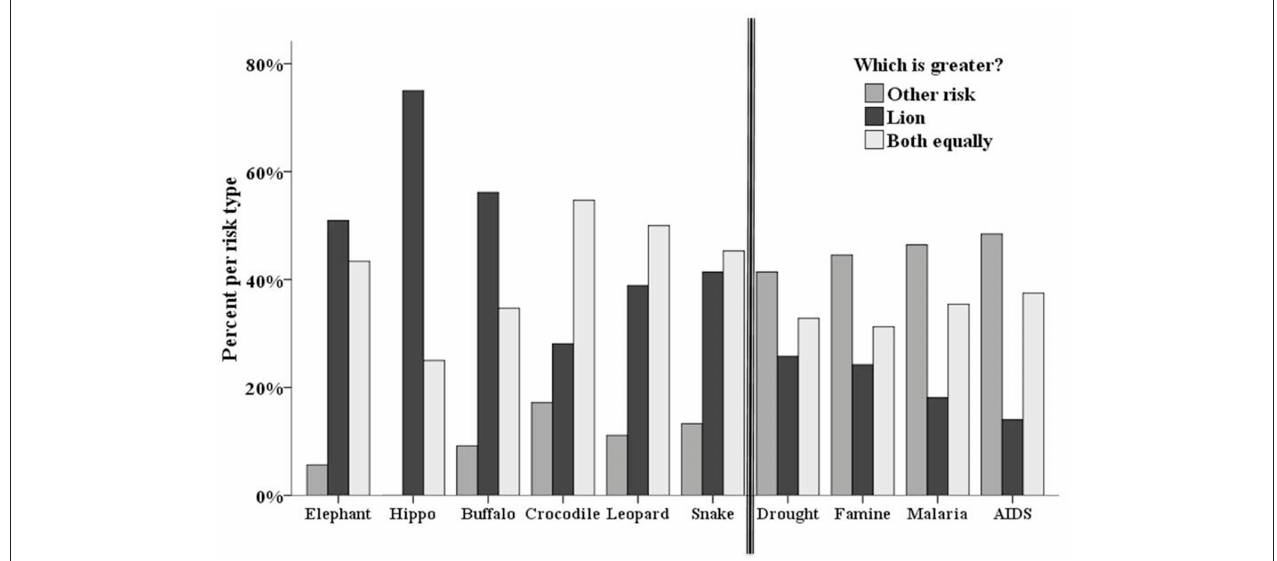
FIGURE 3 | Comparison of risk between lions and other wildlife (Left) and non-wildlife (Right) risks. Most people view the risk from lions to be greater than elephant, hippo, and buffalo and the same as crocodile, leopard, and snakes. Most people view drought, famine, malaria, and AIDS to be greater than the risk from